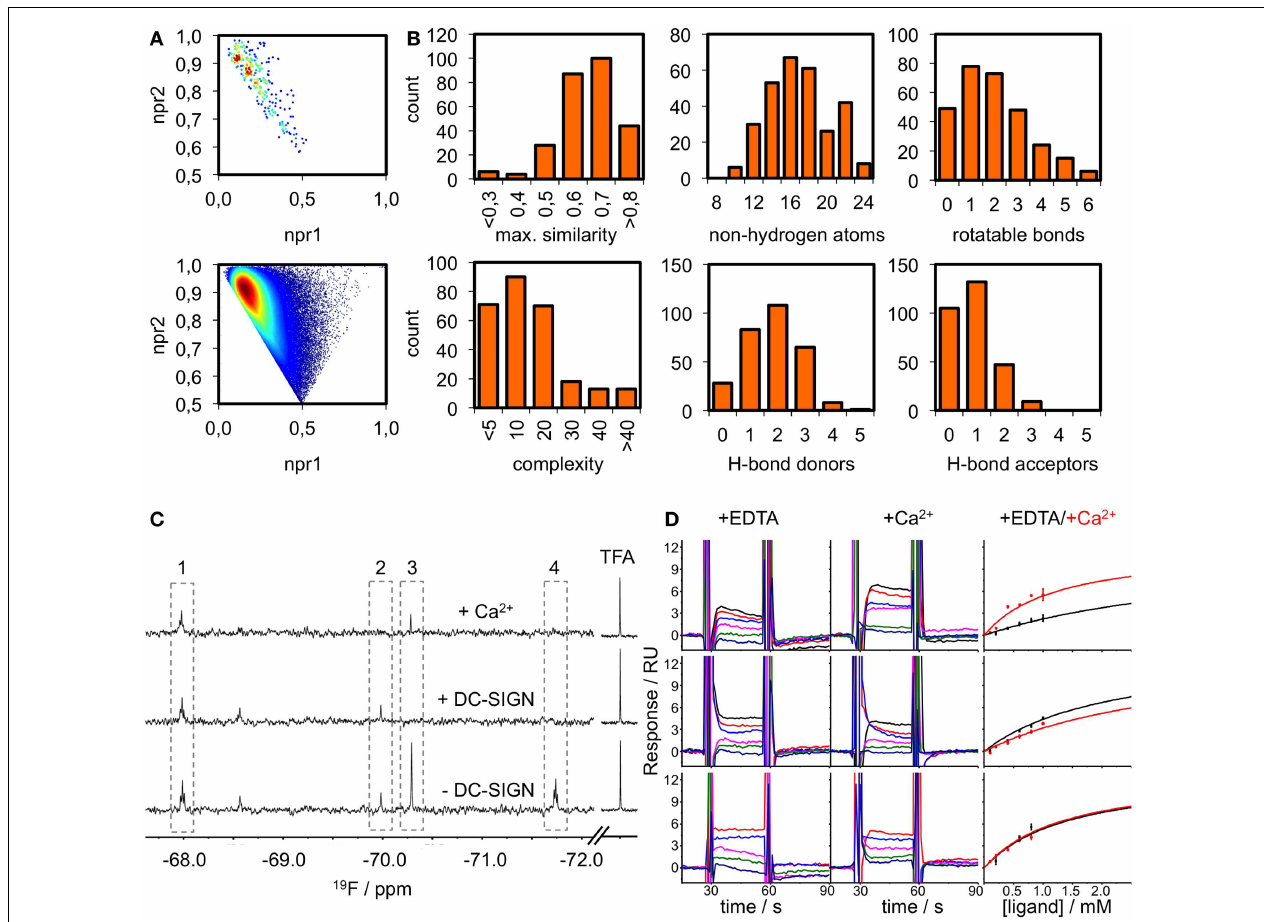
compounds that do not bind (1), bind Ca 2 + -dependently (2), are competed by Ca 2 + (3) and are binding at another binding site (4). (D) Sensorgrams for three examples from the SPR follow-up are shown. DC-SIGN ECD was immobilized on a CM7 chip. A one-site-binding model was used for fitting the data.This exemplifies compounds that experience increased (top), decreased (middle), or no alteration of affinity (bottom) in the presence of Ca 2 + . Data were extracted from regions of the sensorgram not perturbed by injection peaks. SPR sensorgrams are representatives of three independent